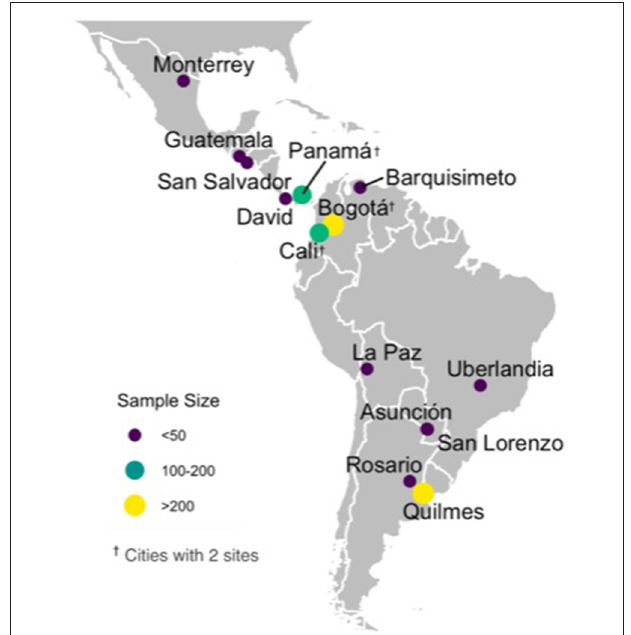
FIGURE 1 | SLIPE-COVID research network-city locations and